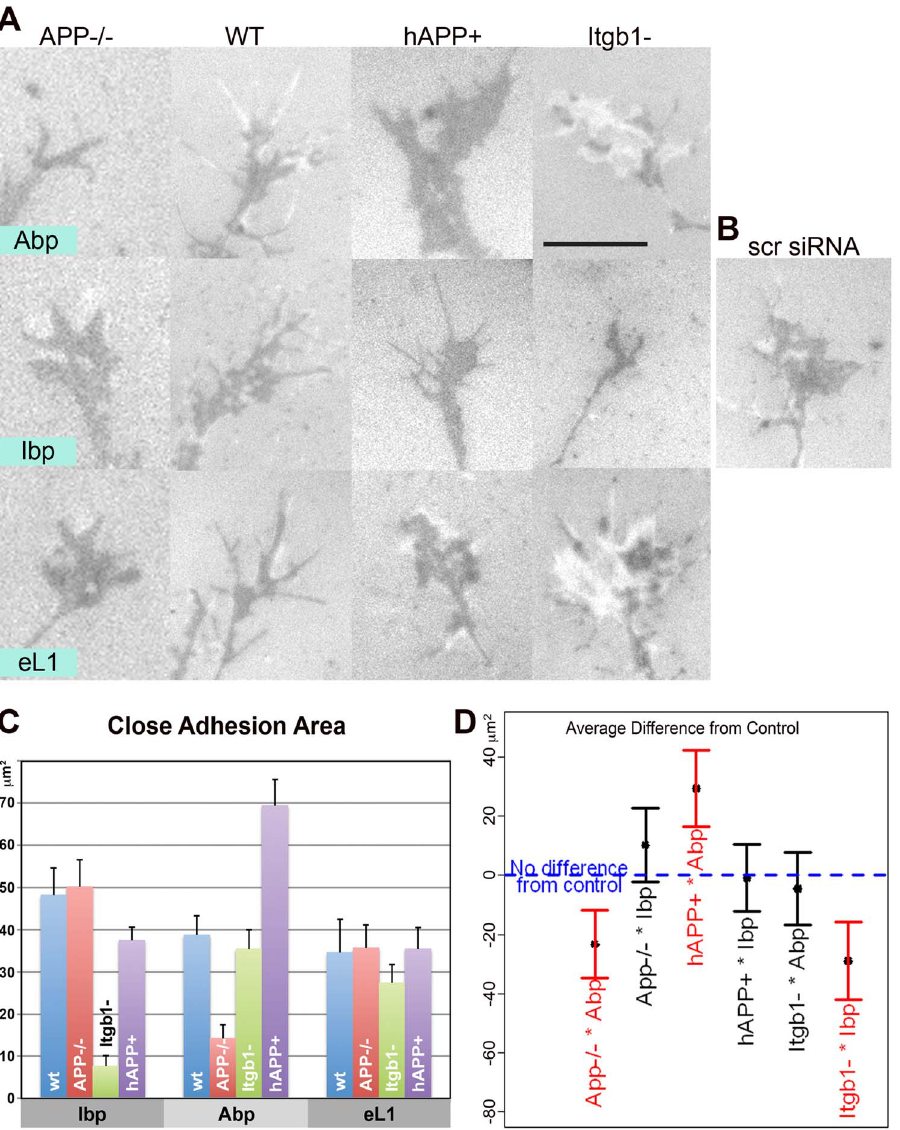
Figure 6. GC adhesion of APP mutant and Itgb1 2 deficient mouse neurons to mono-specific matrices. A. RICM of live GCs of mutant neurons (columns) on different matrices (rows). Dark areas indicate close adhesions, bright areas are wider contacts. Scale 10 m m. Note different adhesive areas of APP 2 / 2 and hAPP + GCs on Abp, and of the Itgb1 2 GC on Ibp. B. RICM image of live GC of a neuron transfected with scrambled siRNA on Ibp [control for adjacent image (Itgb1 2 on Ibp)]. C. Cumulative close adhesion areas of GCs in different neuron*matrix combinations (means 6 s.e.). D. Average difference of close adhesion areas from control group and the associated 95% confidence intervals for the tested neuron*matrix combinations. Negative values indicate reduced and positive values indicate increased areas. Only the values for APP 2 / 2 and hAPP + neurons on Abp, and for Itgb1 2 neurons on Ibp are significantly different (red).